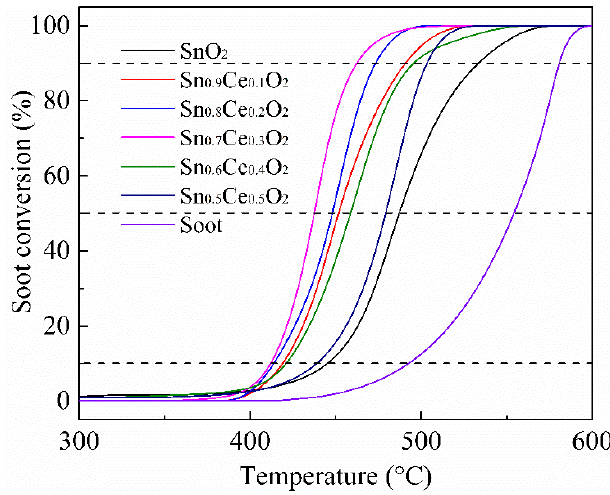
Figure 12. TPO profiles of the SnO 2 and Sn x Ce 1-x O 2 fiber catalysts.